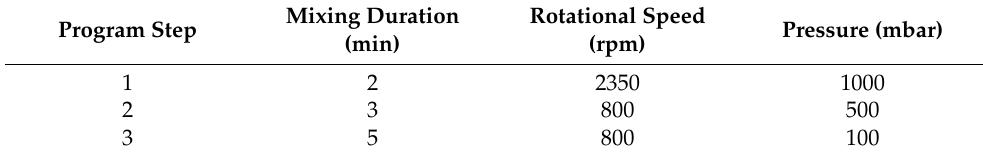
Table 4. Program for preparing and degassing glass